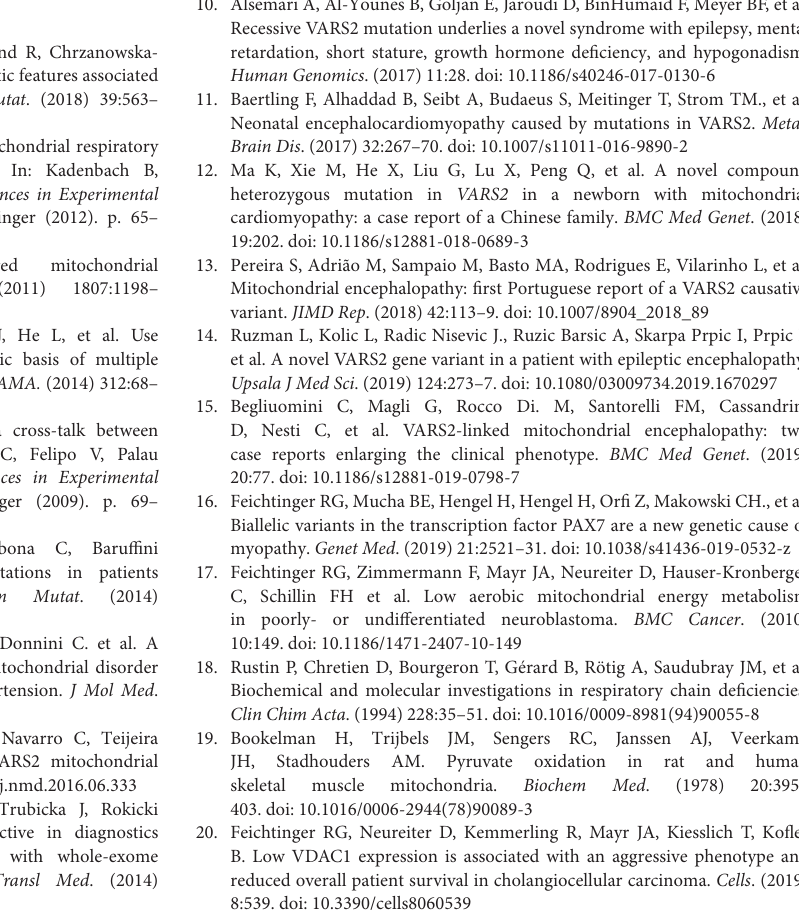
western blot. Supplementary Figure 2 | Immunohistochemical staining of VDAC1 and subunits of the OXPHOS complexes in skeletal muscle of affected individual and controls. (A–C) VDAC1 staining; (D–F) NDUFB8 staining; (G–I) SDHA staining; (J–L) UQCRC2 staining; (M–O) MT-CO1 staining; (P–R) ATP5F1A staining; (A,D,G,J,M,P) control 1; (B,E,H,K,N,Q) control 2; (C,F,I,L,O,R) affected individual. Images were taken with a 400x magnification. A slight reduction of NDUFB8 and UQCRC2 was present in muscle of the affected individual compared to